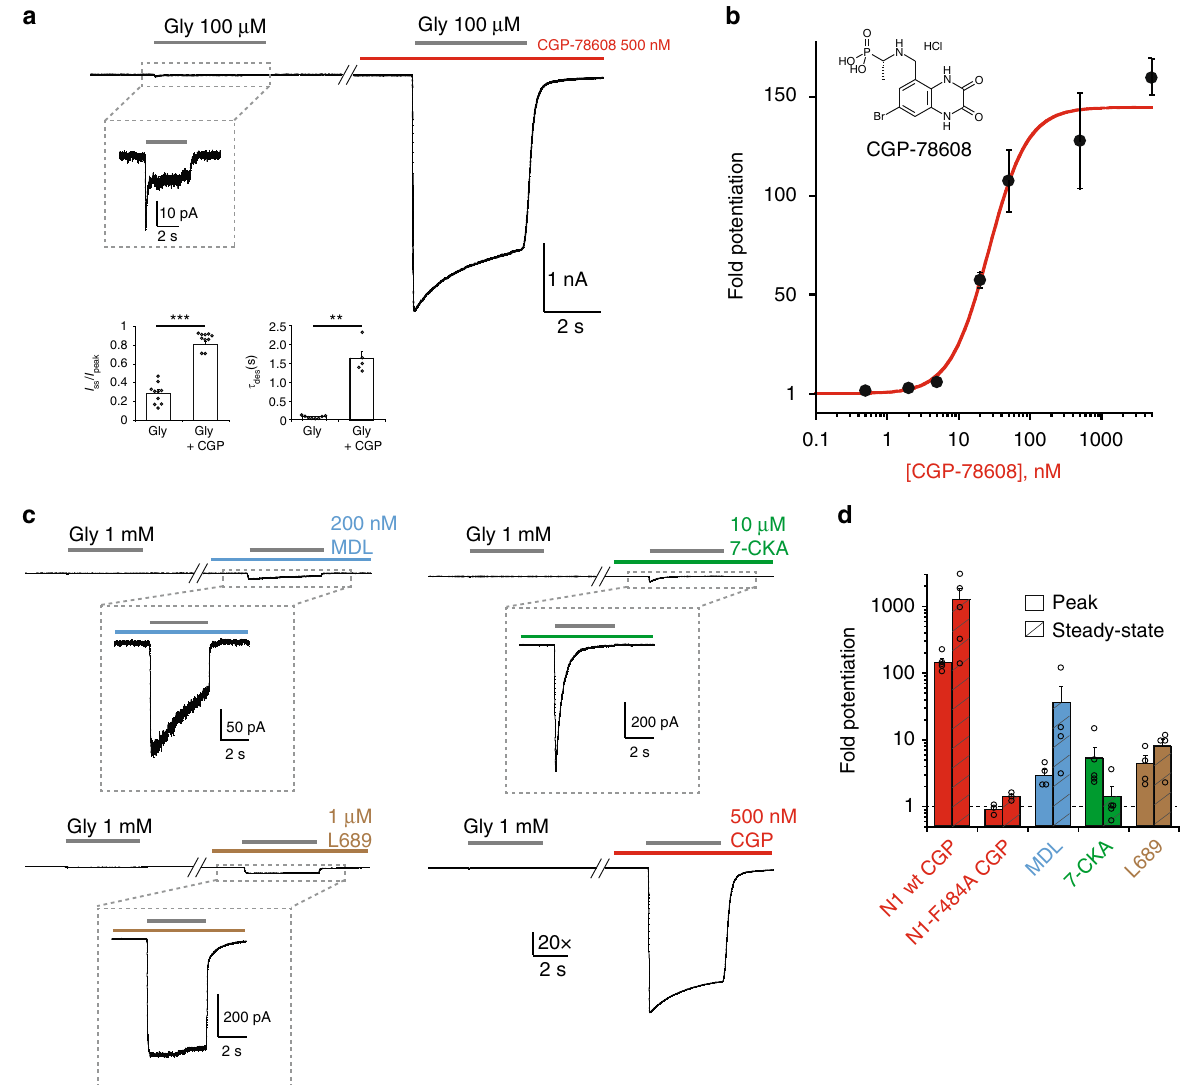
Fig. 1 The GluN1 antagonist CGP-78608 awakes GluN1/GluN3A receptors. a Pre-application of CGP-78608 massively potentiates excitatory glycine GluN1/GluN3A receptor responses. Bar graphs indicate effect on extent ( I ss / I peak ) and kinetics ( τ des ) of desensitization. *** P < 0.001, Student ’ s t -test, ( n = 10); ** P = 0.002, Mann – Whitney test ( n = 10). b CGP-78608 potentiation dose-response curve obtained in presence of 100 µ M glycine. Currents were measured at the peak. EC 50 = 26.3 ± 5 nM, n H = 1.45 ( n = 4 – 11). c Representative current traces showing the relative potentiation of various GluN1 antagonists compared to CGP-78608. Traces are normalized to the glycine-induced peak currents obtained prior to drug application. d Quanti fi cation of effects of GluN1 antagonists tested in c on peak and steady-state current levels ( n = 4-6). N1-F484A refers to the GluN1-F484A mutant subunit.